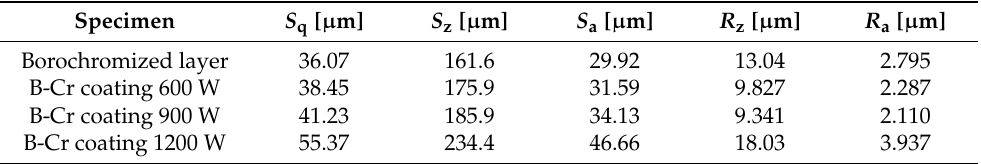
Table 5. Results of roughness parameters after wear resistance tests for diffusion borochromized layer and B-Cr coatings produced using laser